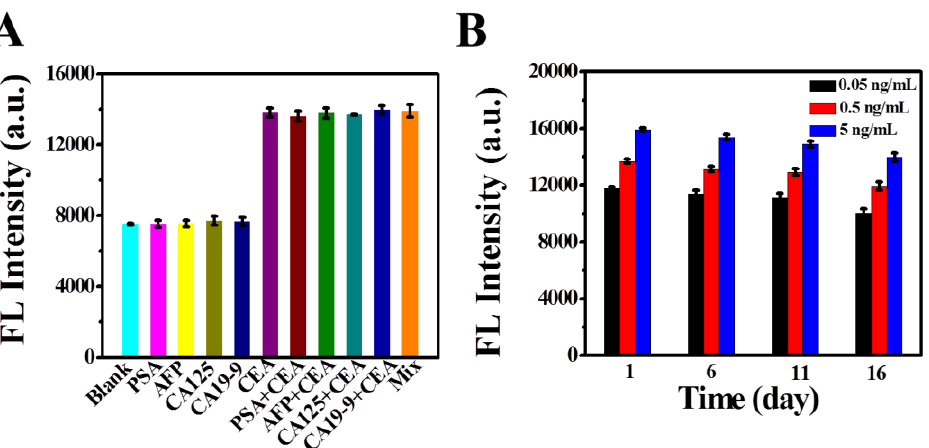
Figure 6. ( A ) Selectivity for the determination of CEA by monitoring the fluorescence intensity with different interfering species (error bars: SD, n = 3), ( B ) the stability of the FLISA platform for CEA (0.05, 0.5, 5 ng mL −1 ) (error bars: SD, n = 3).